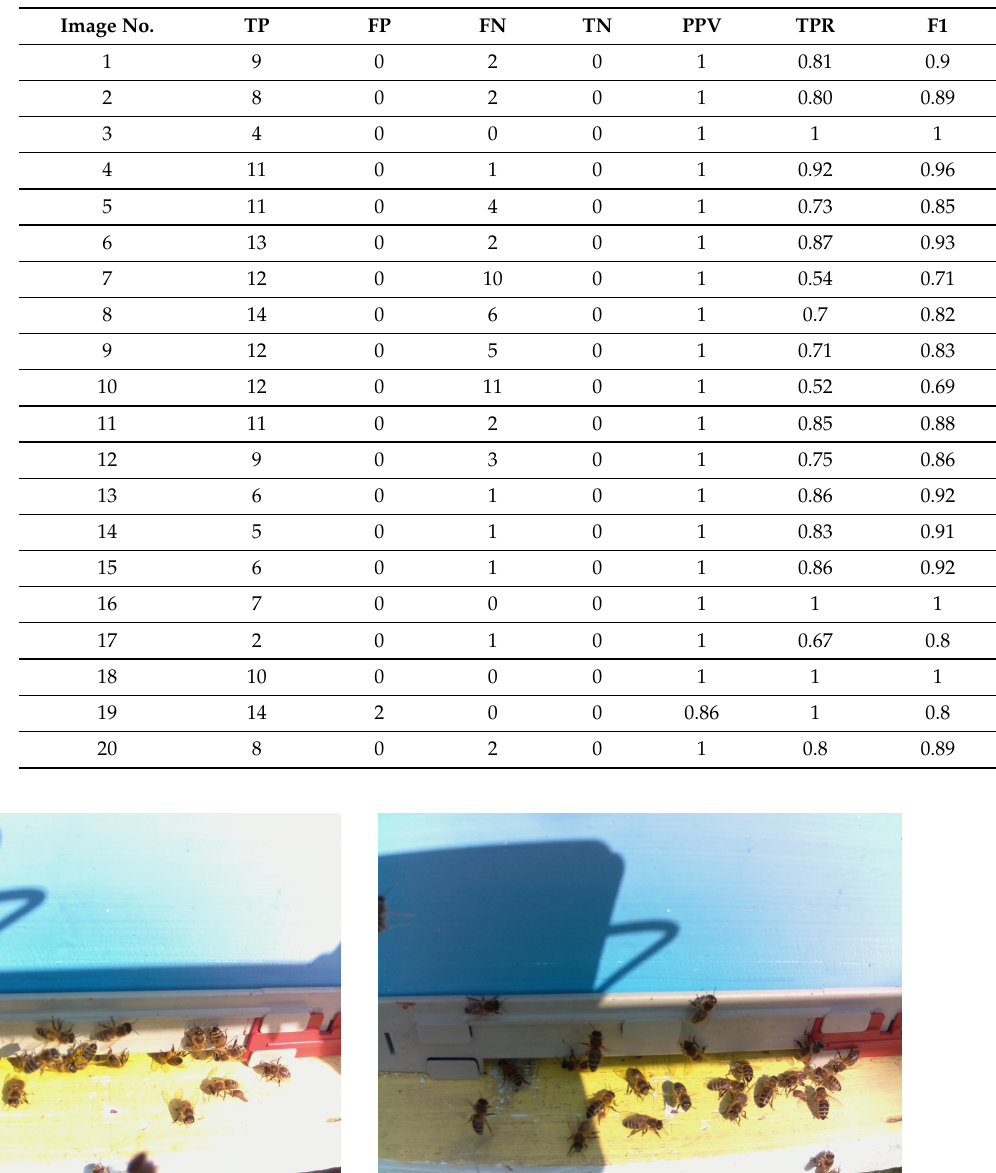
Table 2. Effectiveness of bee identification for various images (video frames).